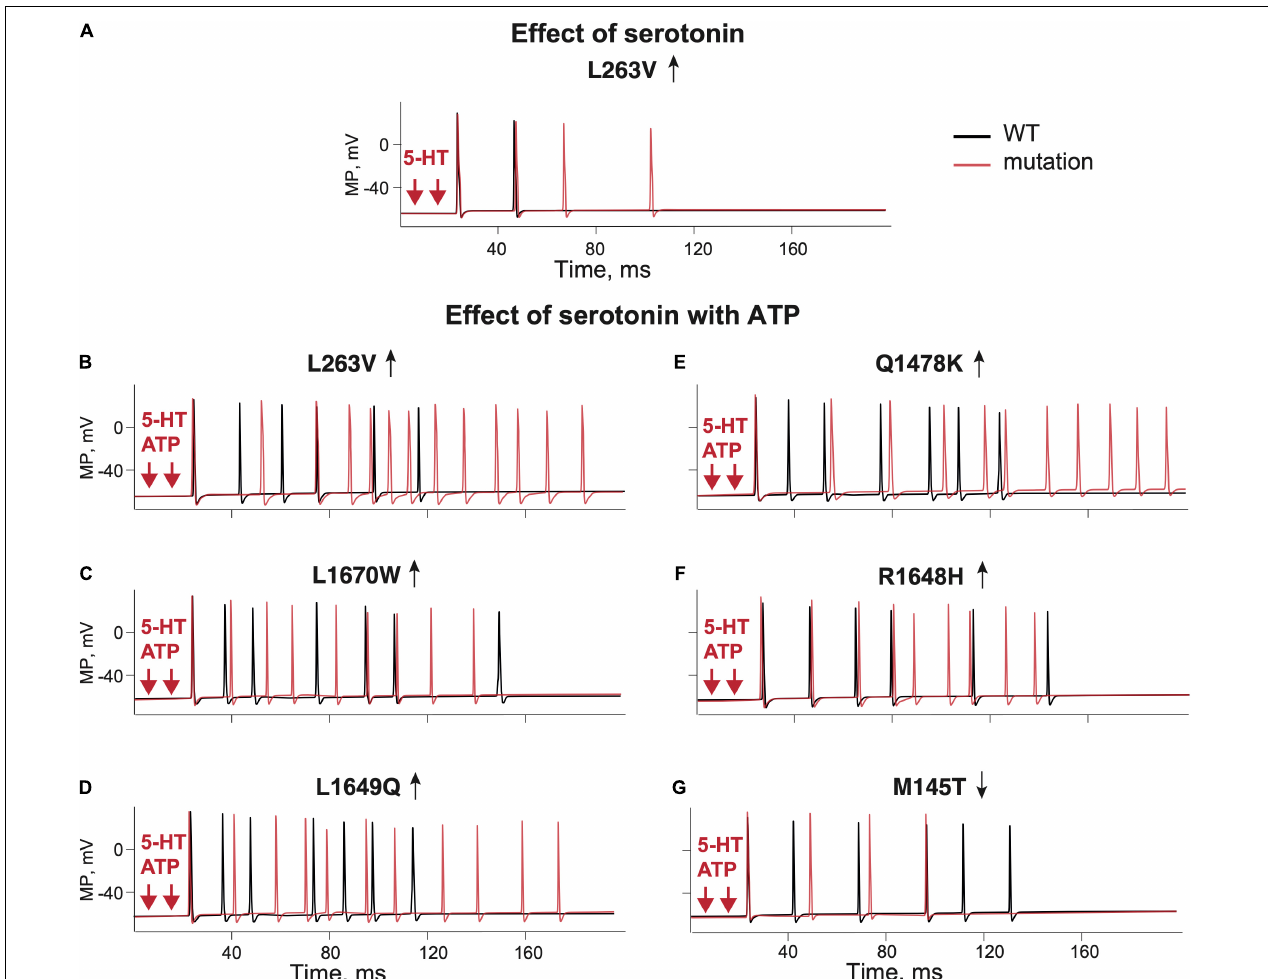
FIGURE 5 | The role of 5-HT and combination of ATP and 5-HT release events in firing of the WT and Na V 1.1 mutant branching A δ -fibers. (A) Firing of the WT (Kahlig et al., 2008) fibers (black line) and the L263V mutant (red line) activated by two 5-HT release events. (B) WT (Kahlig et al., 2008) fibers (black line) and the L263V mutant (red line) activated by ATP + 5-HT release events. (C) The L1670W mutant fiber (red line) and WT (Dhifallah et al., 2018) fiber (black line) activated by ATP + 5-HT release events. (D) The L1649Q mutant fiber (red line) and WT (Cestele et al., 2008) fiber (black line) activated by ATP + 5-HT release events. (E) The Q1478K mutant fiber (red line) and WT (Cestele et al., 2013) fiber (black line) activated by ATP + 5-HT release events. (F) The R1648H mutant (red line) and WT (Kahlig et al., 2006) fiber (black line) associated with childhood epilepsy gain-of-function of Na V 1.1. (G) The M145T Na V 1.1 mutant (red line) and WT (Mantegazza et al., 2005) fiber (black line) associated with a loss-of-function mutation of Na V 1.1. ATP signaling is limited by partial hydrolysis and 5-HT signals are reduced by specific